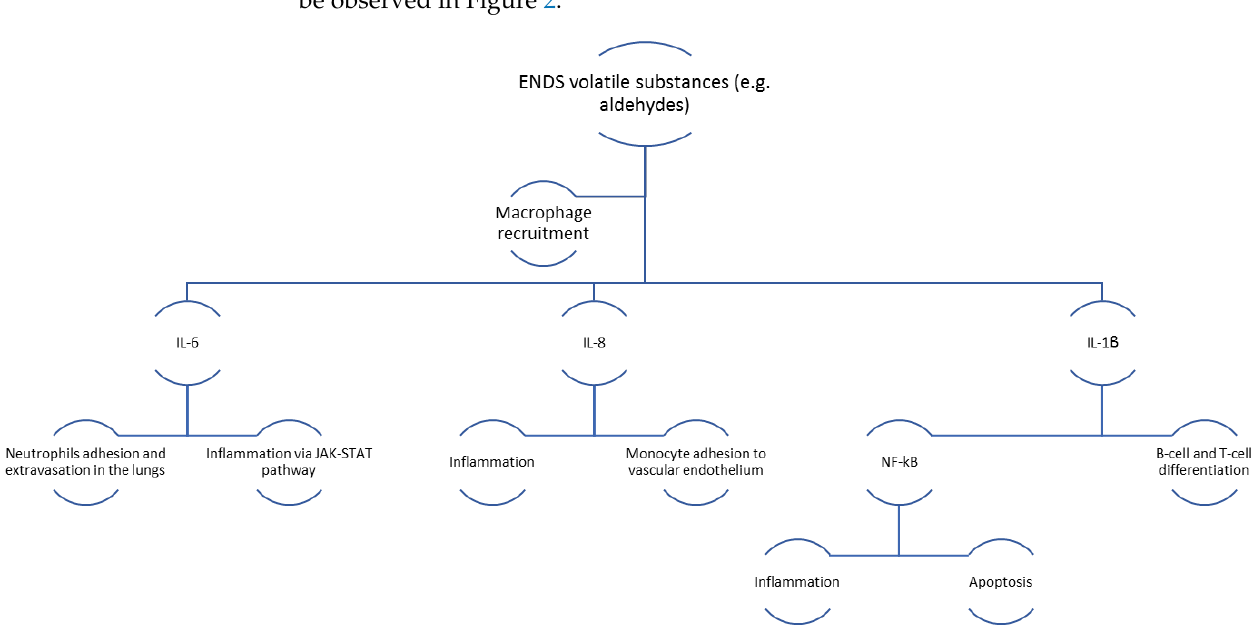
Figure 2. Schematic representation of the primary physiopathological mechanisms triggered by exposure to volatile substances from ENDS.